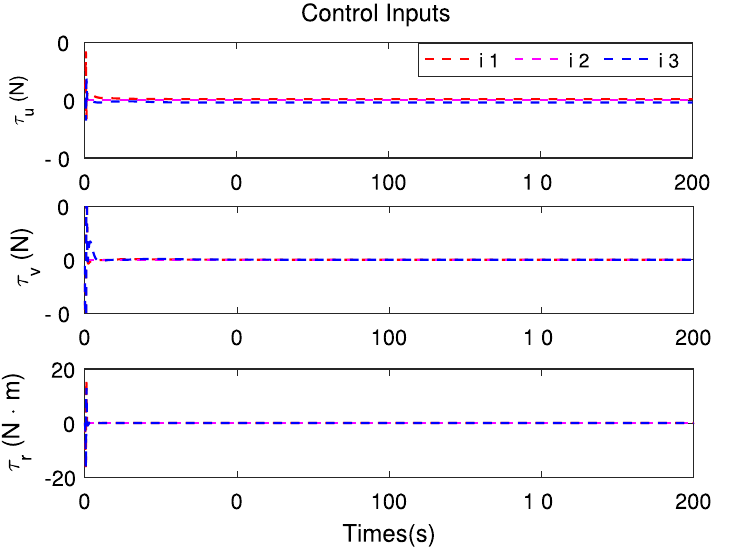
Figure 6. Time response of the control inputs.